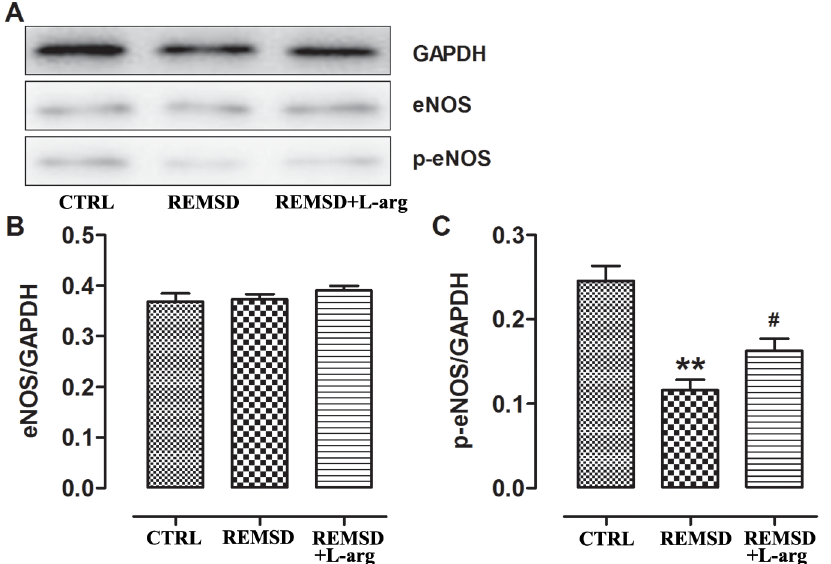
rats Western blotting revealed decreased expression of the phosphorylated eNOS protein in REM sleep-deprived rats. However, the overall level of eNOS protein was not significantly affected by REM sleep deprivation (Fig 5).